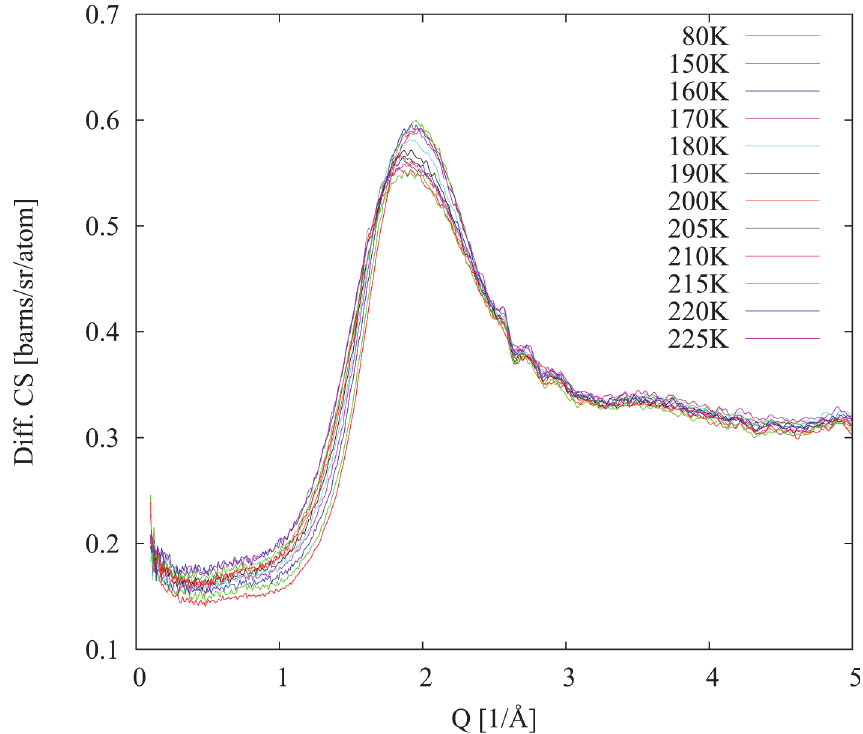
Fig 1. Differential cross sections for fully deuteriated sample. Heating after initial quench